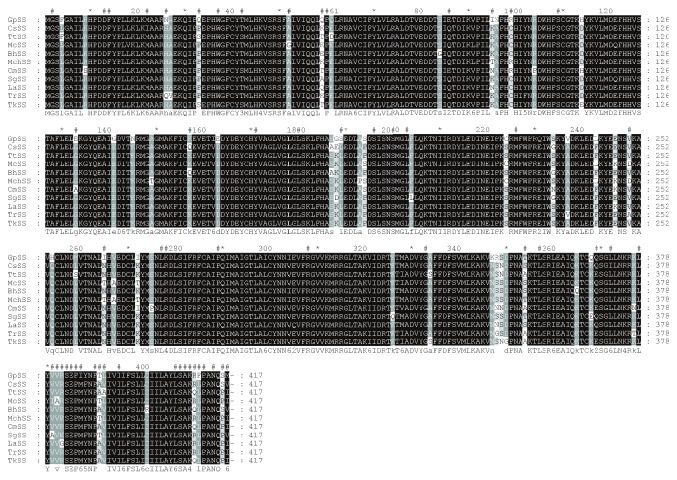
Multialignment of partial terrestrial plant SQS amino acid sequences. Sites of positive selection of SQS above 11 common medicinal Cucurbitaceae plants are shown through the Gendoc software, and GpSS was used as the reference sequence. Conserved sites are shaded, and the meaning of each symbol is given in the specific symbol. #Positively selected site.